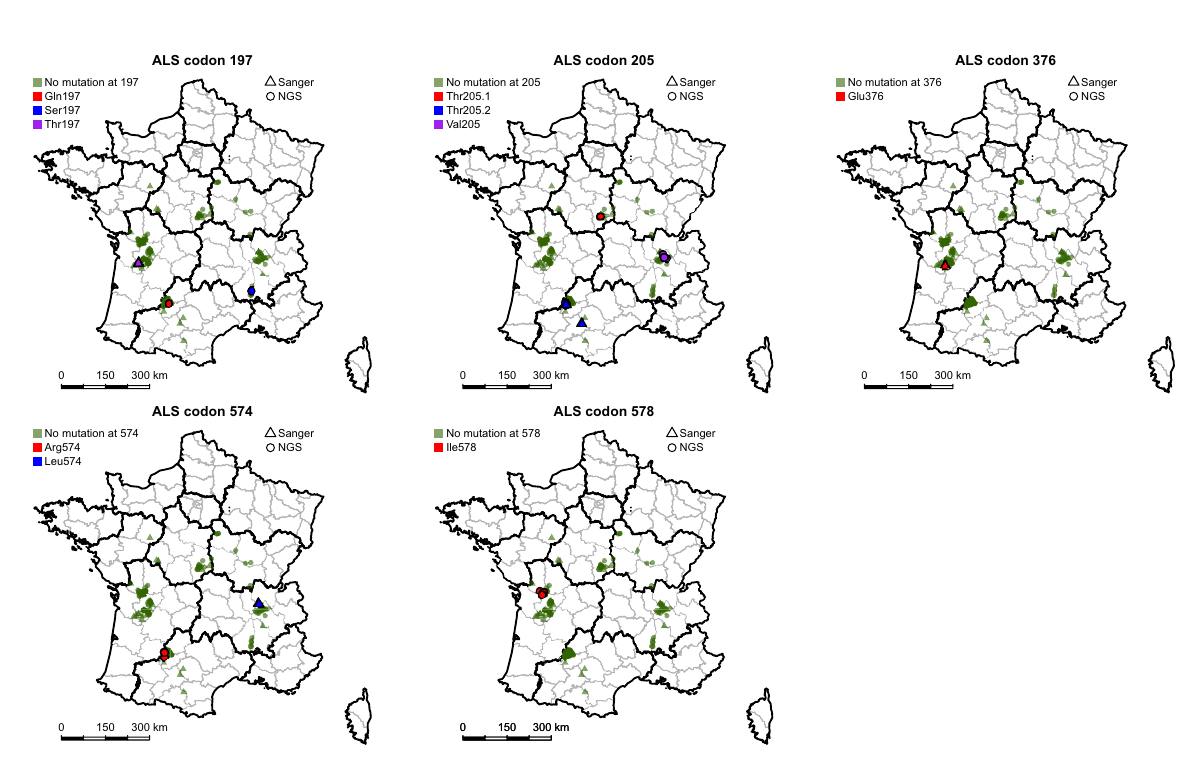
Figure 1. Geographical distribution of the nine mutant ALS alleles identified in this study among common ragweed populations. The results obtained by Pool-seq analysis of the random sampling of 213 populations and by Sanger sequencing of resistant plants from the targeted sampling of 43 additional populations are illustrated together. Green dots, populations where no allele mutant at the considered codon was detected. Coloured dots, populations where mutant ALS alleles were detected by pool-seq. Coloured triangles, populations where mutant ALS alleles were detected by Sanger sequencing. Maps generated using R software (v4.1.0, packages rgdal, rgeos and